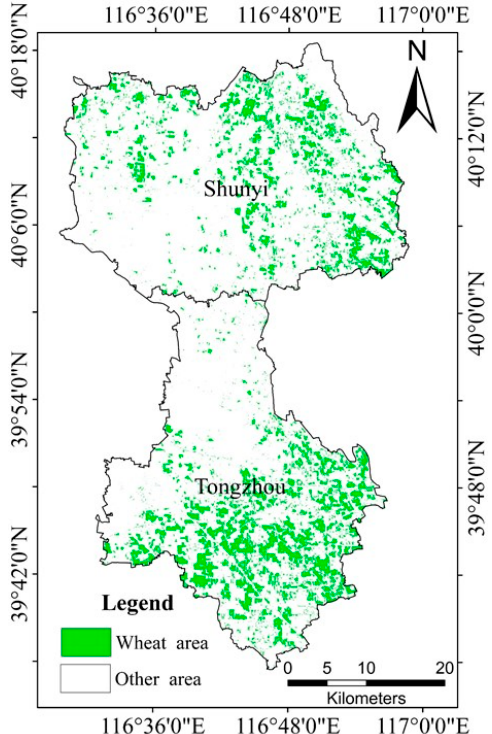
Figure 2. Winter wheat planting area in Tongzhou and Shunyi districts of Beijing in 2009.